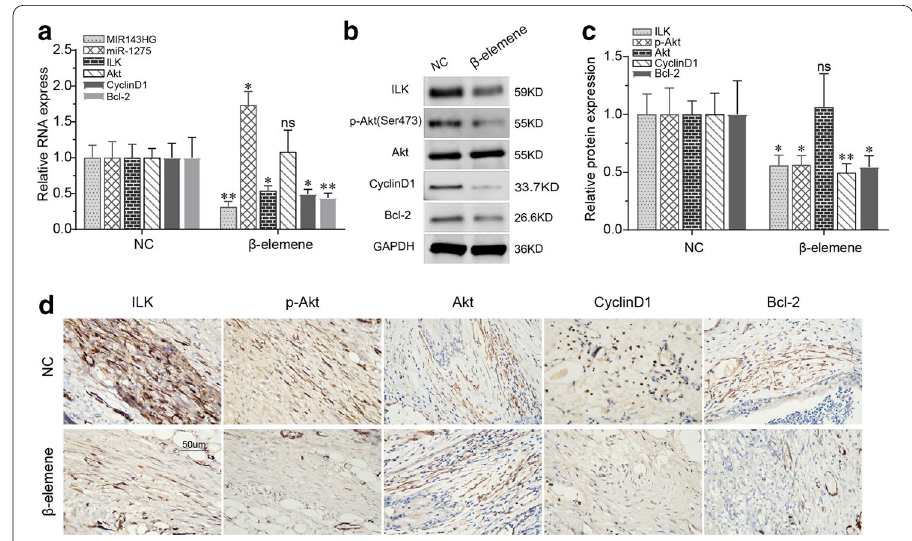
Fig. 9 β-Elemene affected MIR143HG/miR-1275/ILK axis and ILK/Akt pathway in vivo. a – c RT-qPCR and Western blotting were used to detect activity of the MIR143HG/miR-1275/ILK axis and ILK/Akt pathway in rabbit models treated with β-elemene. * P < 0.05, ** P < 0.01; ns not significant. d Representative images